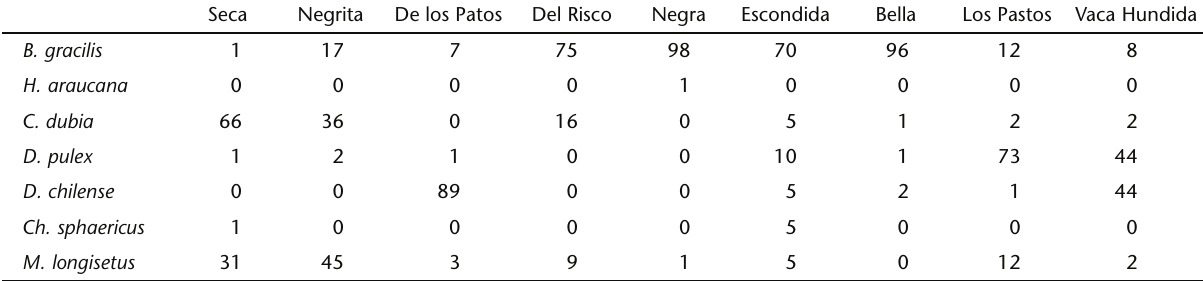
Table III. Percentage of species reported per